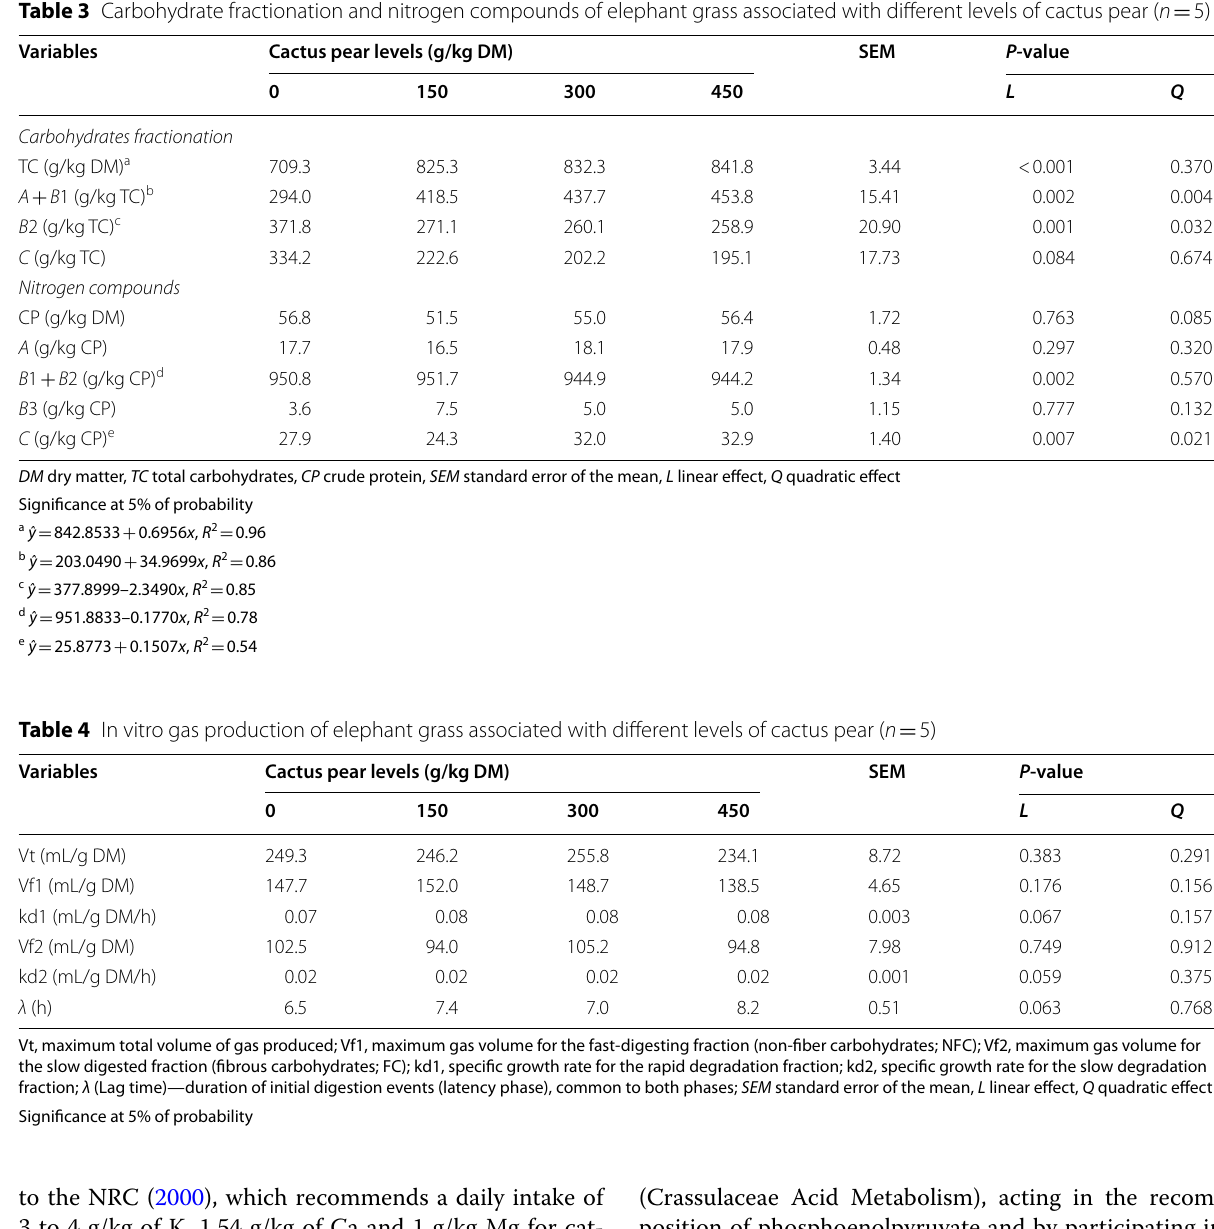
Table 3 Carbohydrate fractionation and nitrogen compounds of elephant grass associated with different levels of cactus pear ( n